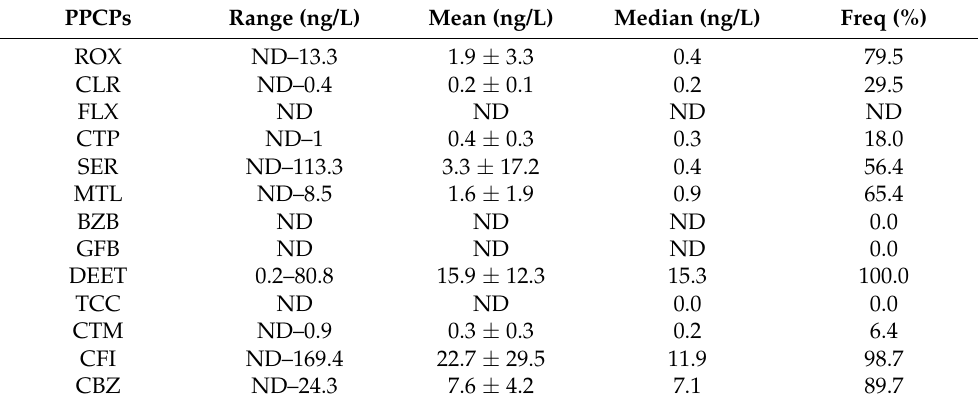
Table 3. Detection frequency and concentration range of the PPCPs in Taihu